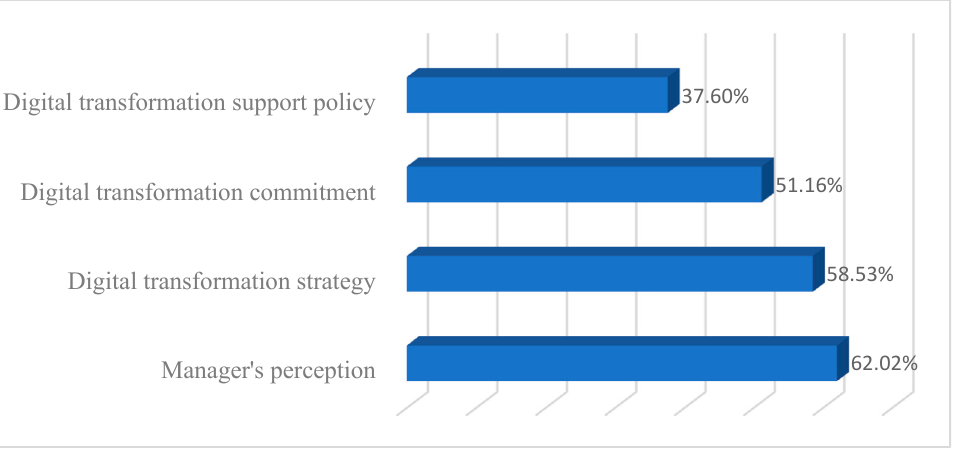
Figure 5. Managers’ commitment.